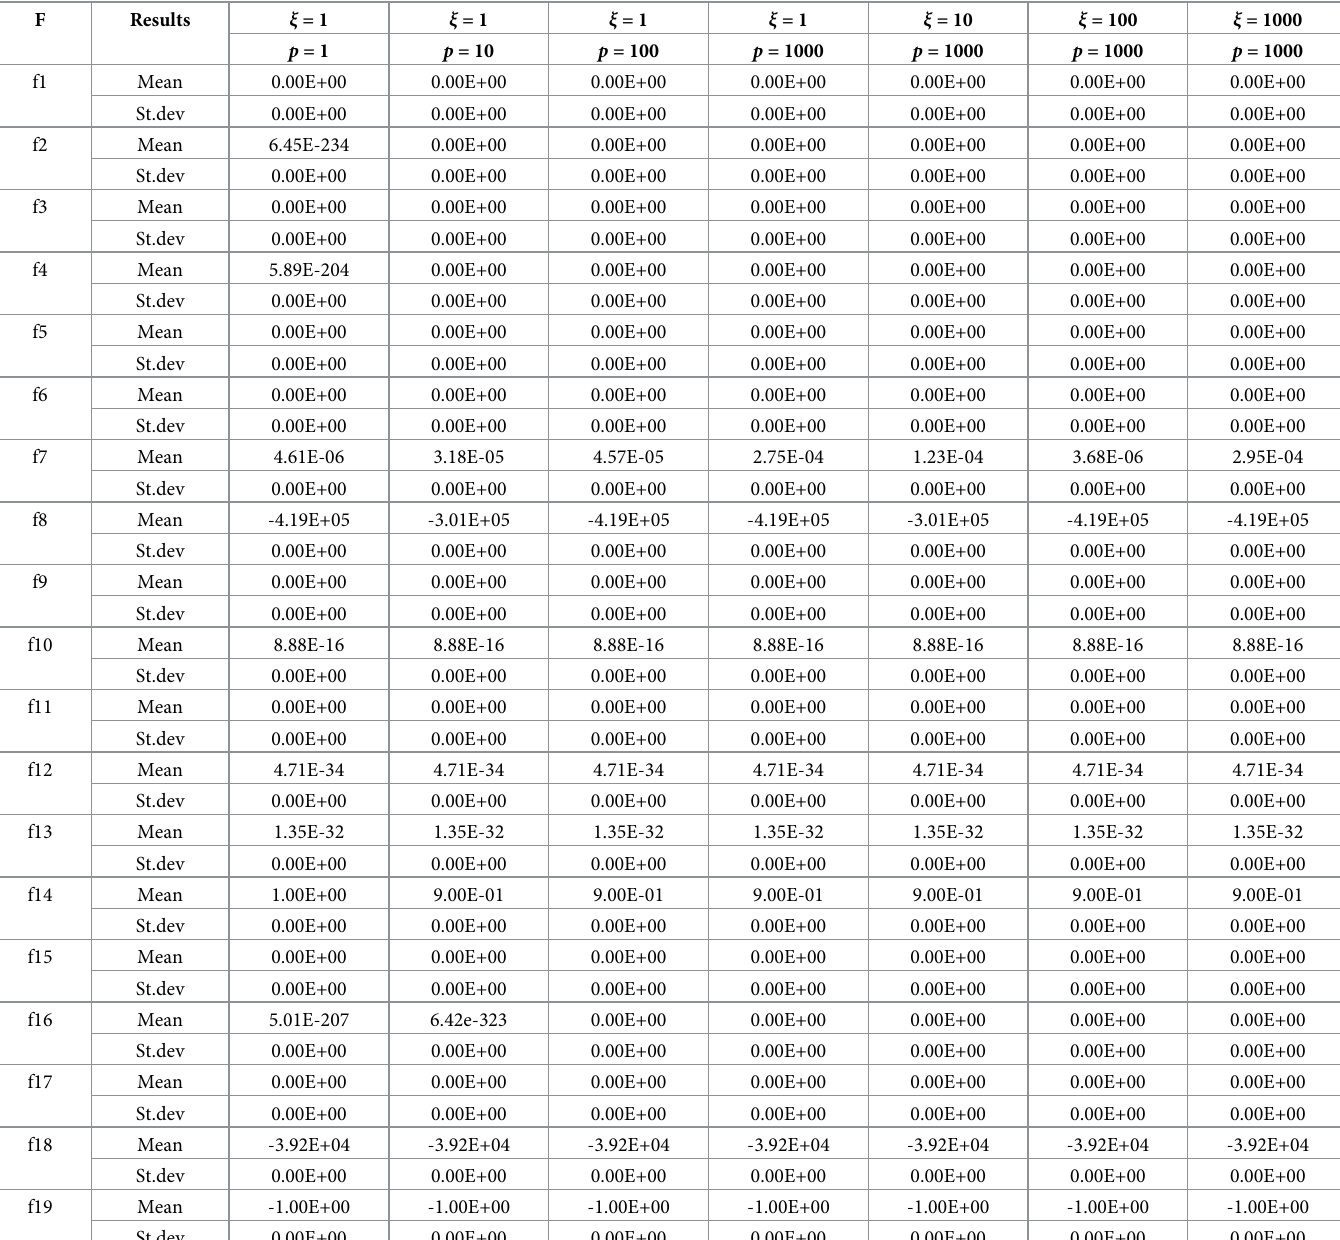
Table 12. Experimental results of CRLPO for 19 test functions with typical combinations of ξ and p (Dim =